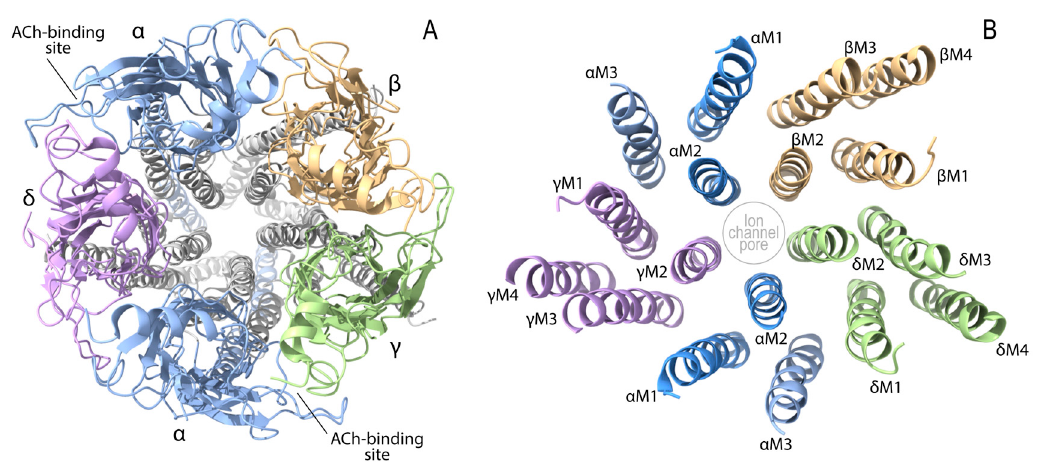
Figure 2. Crystal structure of AChR viewed from the extracellular side (PDB 2BG9) [87]. ( A ) Extracellular domains of AChR subunits. Other domains are shown in gray. ( B ) Transmembrane domains of AChR subunits. α M4 domains are not indicated.